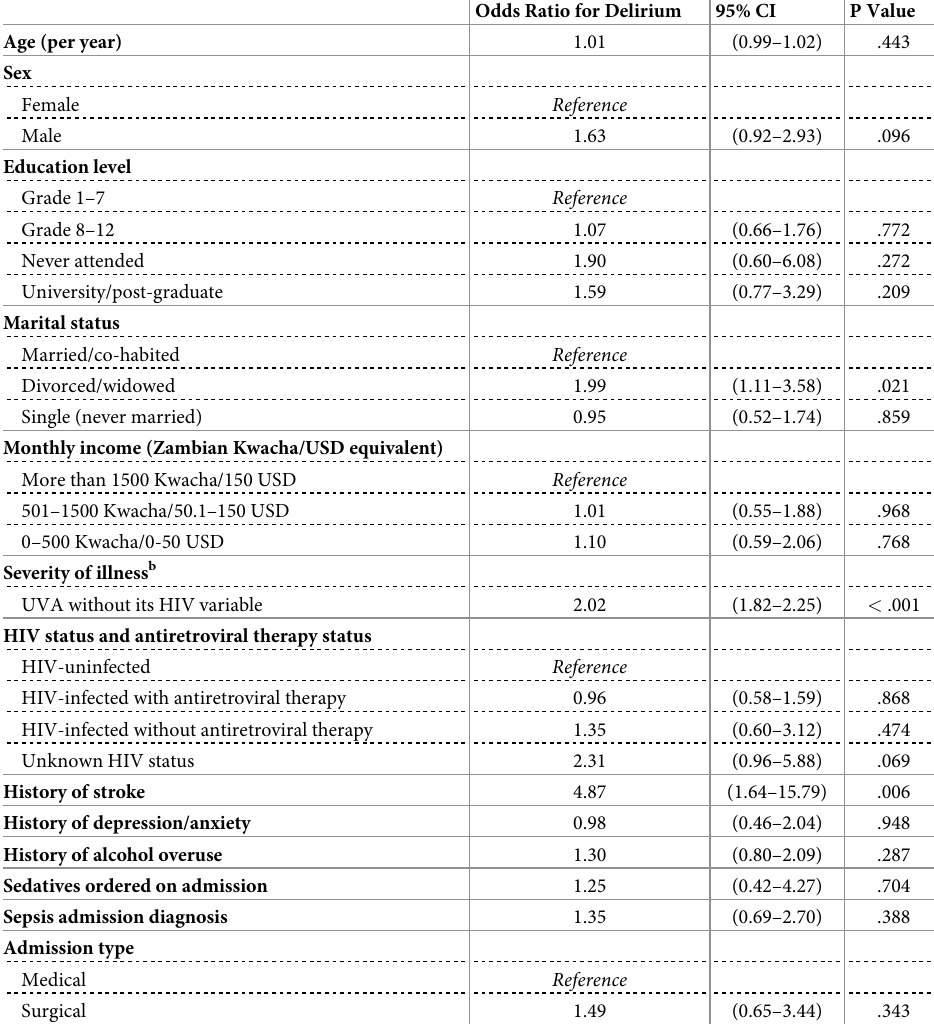
Table 3. Combined multivariable regression analysis a